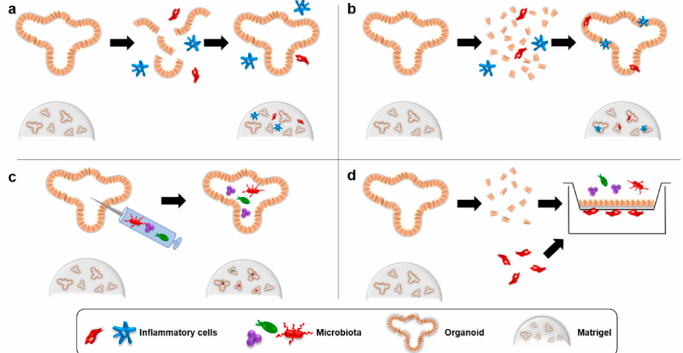
Figure 1. Current strategies for organoid coculture with inflammatory cells. ( a ) To study the interactions of typical stromal cells with organoids, the organoids are typically mildly dissociated and mixed with the cell population of interest in Matrigel in a method called “direct coculture”. Organoids typically rapidly reform leaving the cocultured cells in the surrounding matrix. ( b ) To study how organoid cells interact with intraepithelial cells that might invade a cancer, the dissociation of the organoids is typically more complete, often involving enzymatic digestion, and the dissociated organoid cells are mixed with the cell population of interest in media and centrifuged to bring them into immediate proximity to one another before being resuspended in Matrigel. Organoids reforming under these conditions incorporate the second cell population in direct contact with the basolateral surfaces of the organoid cells. ( c ) To study how cells normally found in a lumenal cavity interact with organoid cells, the cells of interest (typically microbiota) can be introduced into the lumen of intact organoids using microinjection techniques. ( d ) To permit more extensive manipulations, organoids can be dissociated and seeded onto Transwell inserts where the cells reform polarized layers with their apical surface facing the center of the Transwell insert and the basal surface facing the well below. For coculture with inflammatory cells, these populations can be added to the underside of the Transwell or into the upper